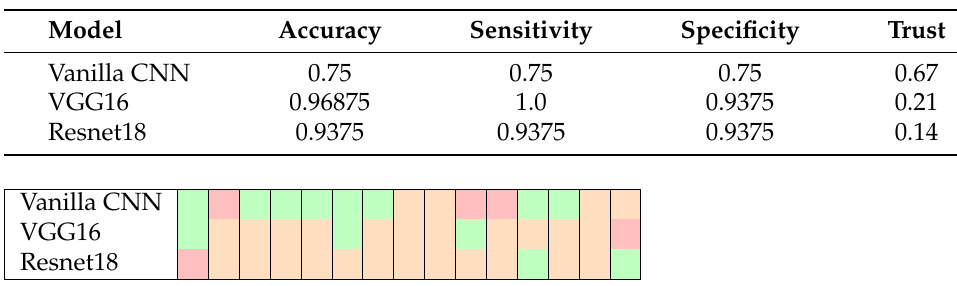
Table 3. Metric comparison including trust score for the three deep learning models.